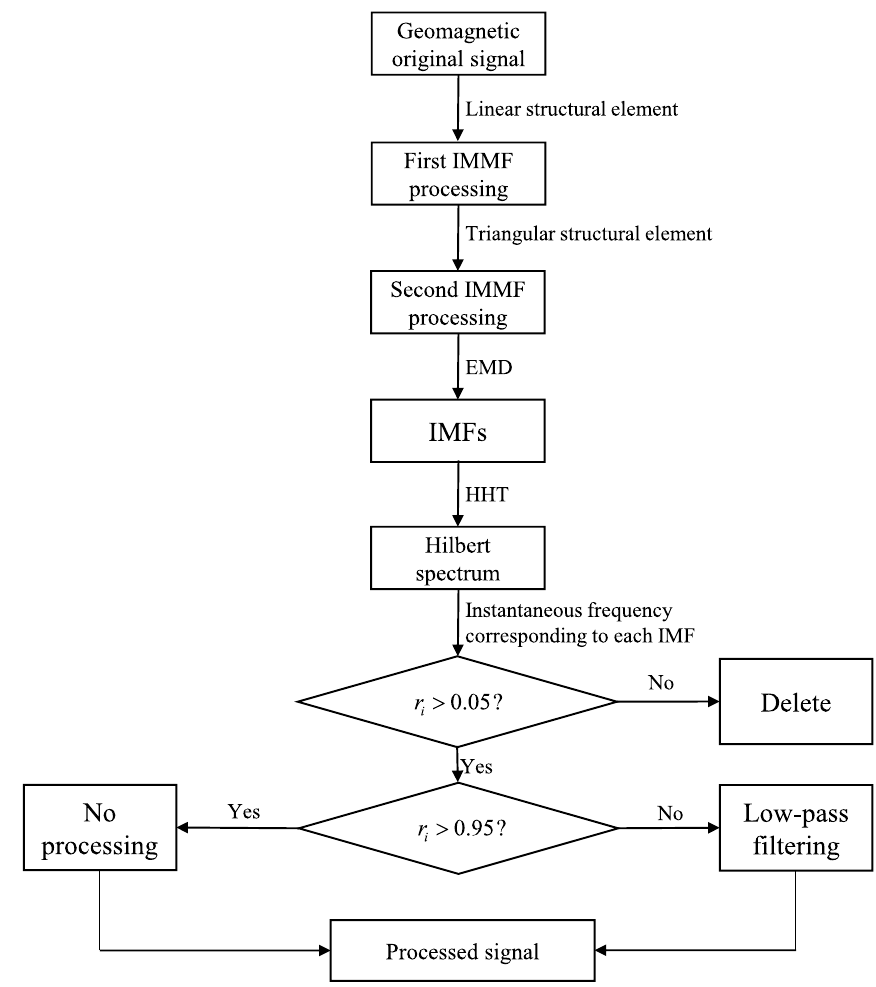
Fig. 1 The overall chain of IMMF–IHHT